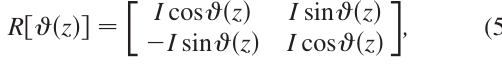
Fig. 8 for ^ B ¼ 0 : 376 T . The beamlets’ trajectories intersect at z ’ 1 : 3 m and the envelopes strongly overlap for z (cid:7) 1 m .